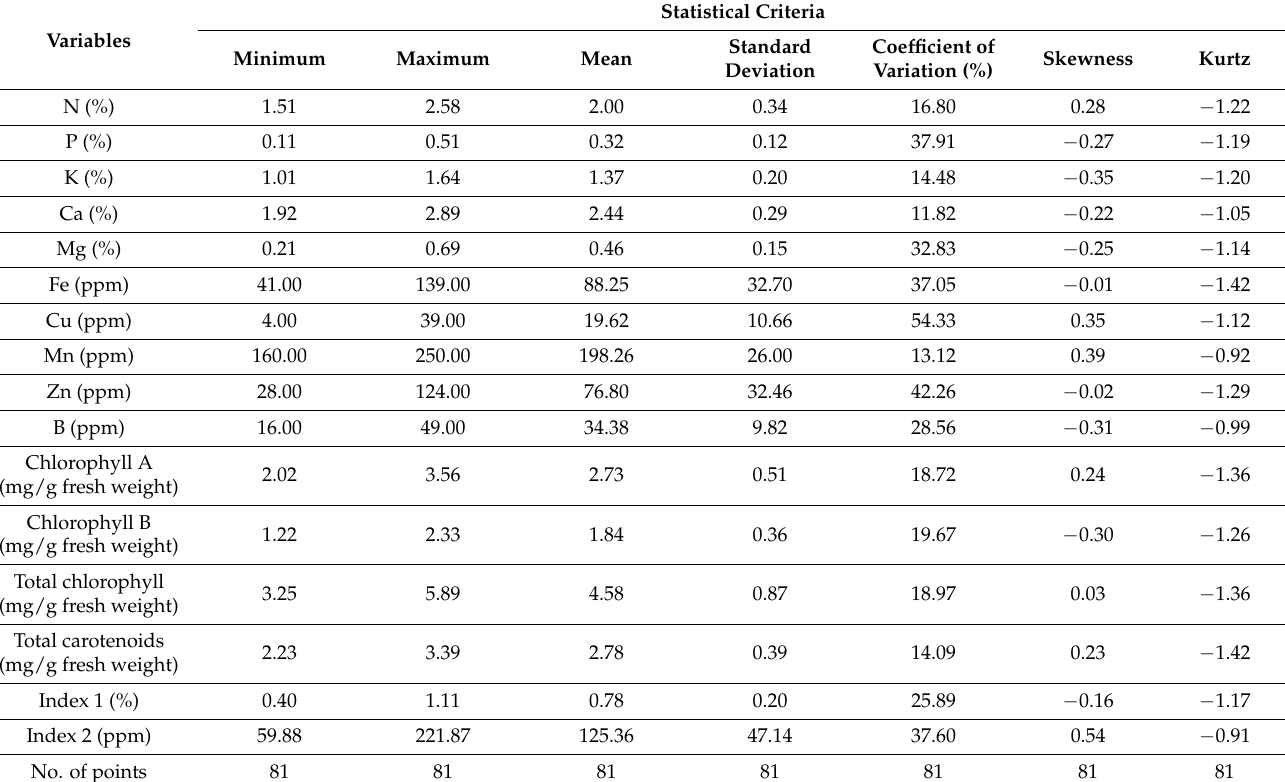
Table 1. Statistical criteria of experimental results for the nutritional status in leaf petioles and leaves of Flame Seedless grape cultivated by different agricultural